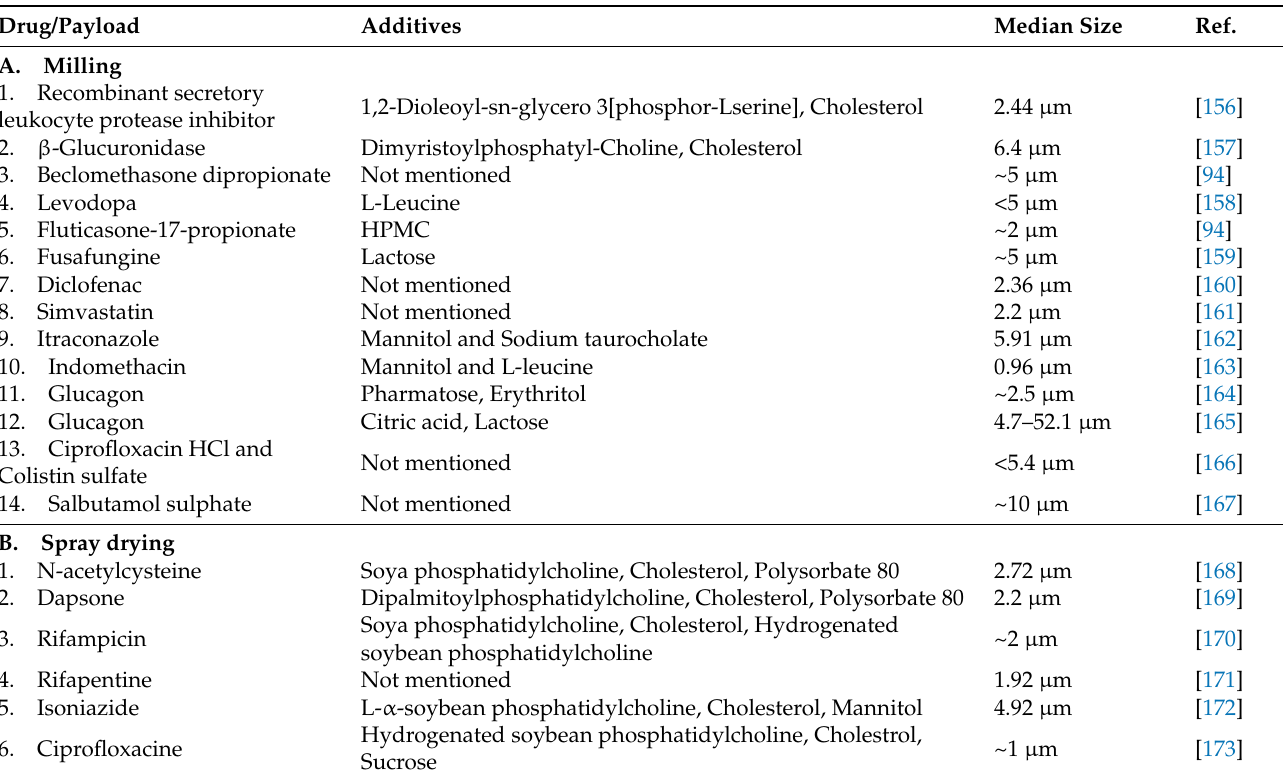
Table 2. Some of the dry powders for inhalation prepared by various techniques. Drug/Payload Additives Median Size